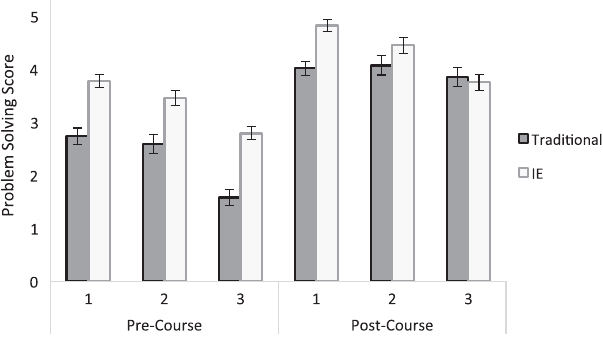
FIG. 1. Pre- and postcourse total problem-solving score as a function of problem number and class format (total possible score ¼ 9 ). Error bars represent the standard